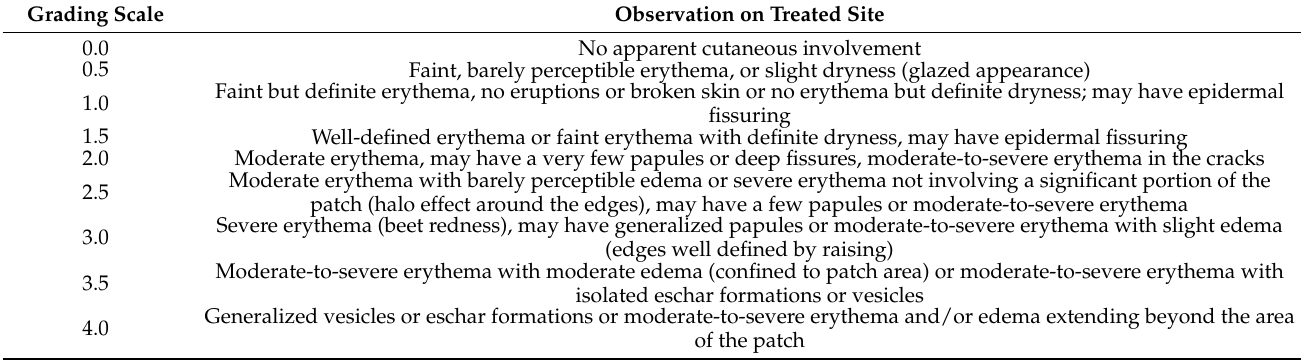
Table 3. Grading scale for skin irritation in clinical